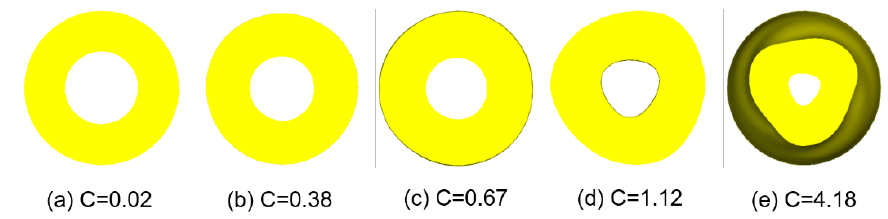
Figure 8. C value level corresponding to different cross-sections.